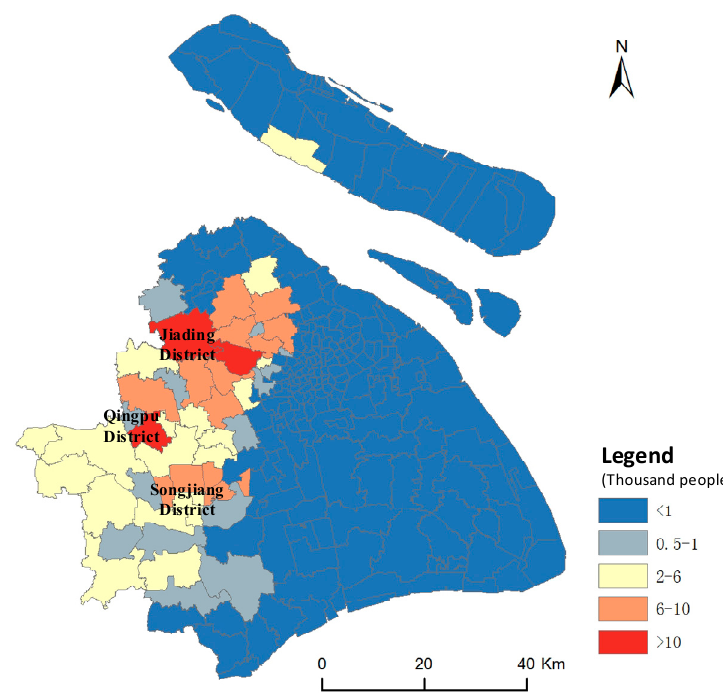
Figure 12. Residential locations with high exposure individuals.